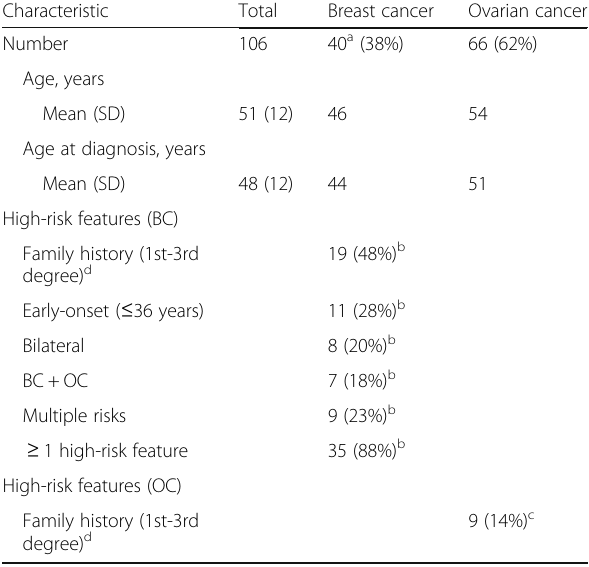
Table 1 Baseline characteristics of the study population